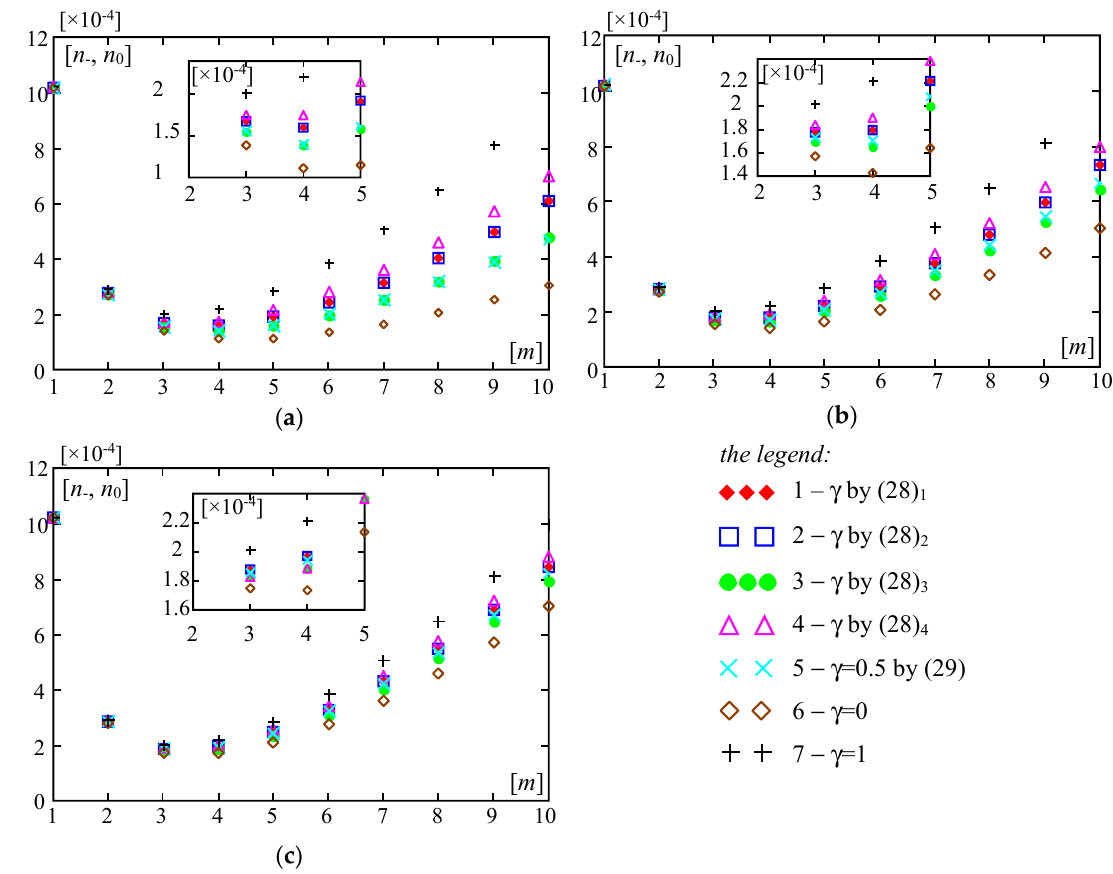
Figure 8. Values of dimensionless parameters n _ , n 0 of critical forces versus numbers of halfwaves of